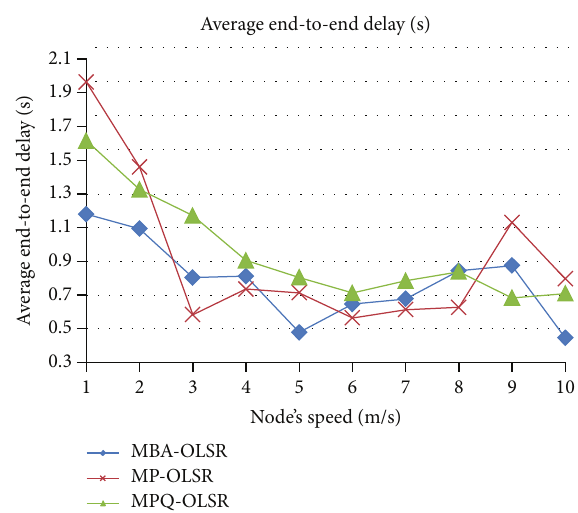
Figure 11: Average end-to-end delay for varying